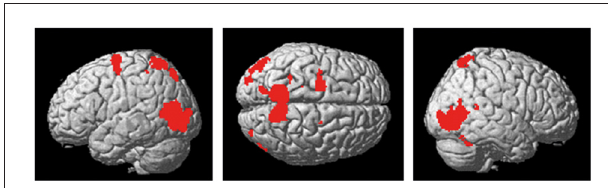
FIGURE 4 | Activity in premotor-, parietal and visual regions, as well as the cerebellum, was evident during the observation of the cross-pass video relative to the control video.